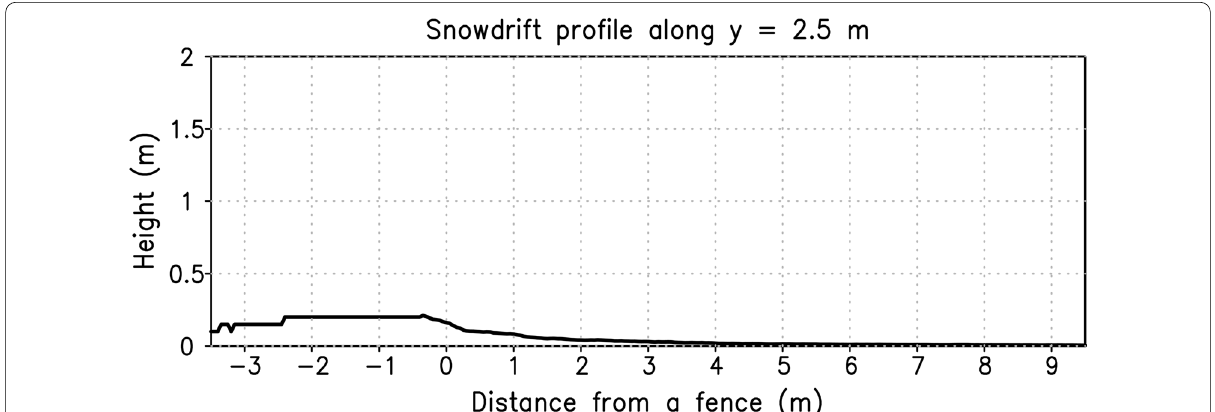
Fig. 6 Snowdrift profile for the no-fence experiment in the cross section along y trajectory